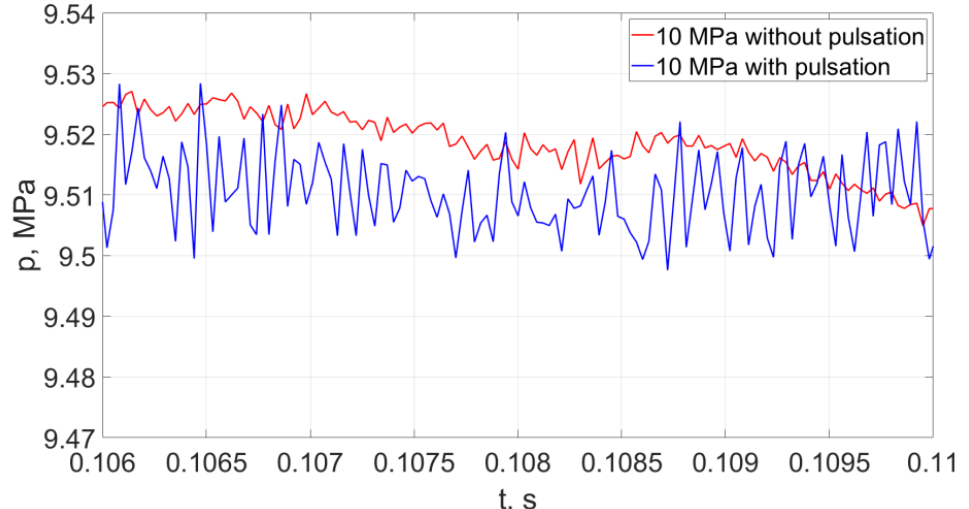
Figure 20. Distributions of hydrodynamic impulses occurring in the water stream (with a pressure of 10 MPa at a distance of 50 mm from the outlet from the pulsating head), produced in the head for drilling holes in the air environment and in the “continuous” stream operating under similar conditions.